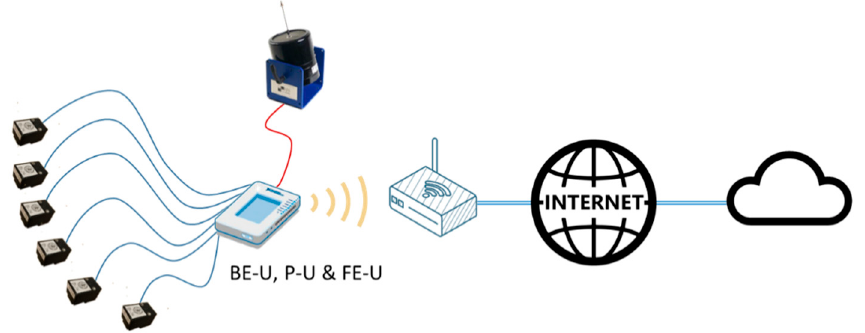
Figure 5. Stand-alone system configuration.